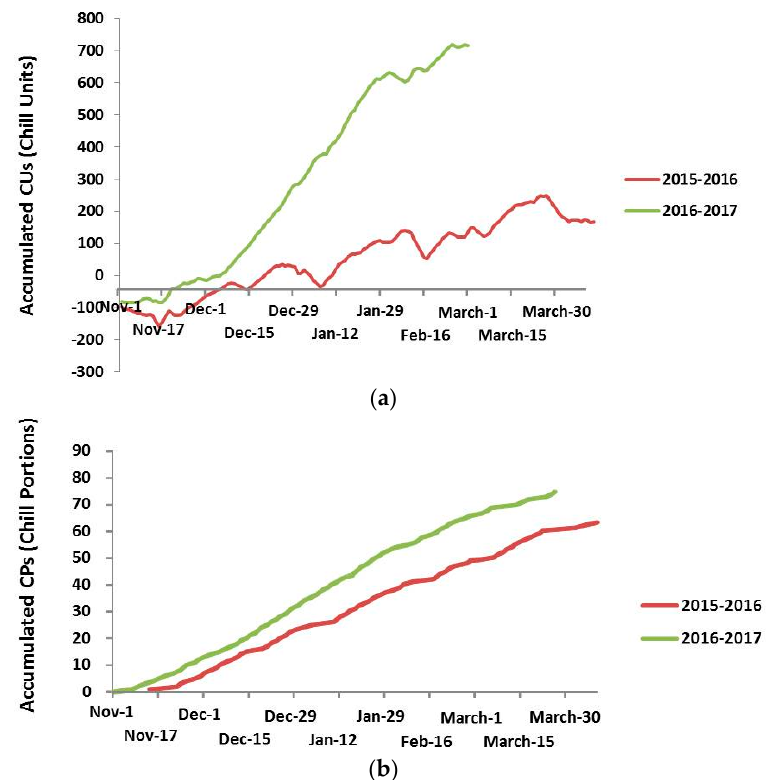
Figure 2. ( a ) Chilling accumulation in field conditions during the two seasons of study (2015–2016 and 2016–2017) calculated as chill units (CUs) according to the Richardson model; ( b ) calculated in chill portions (CPs) according to the dynamic model.